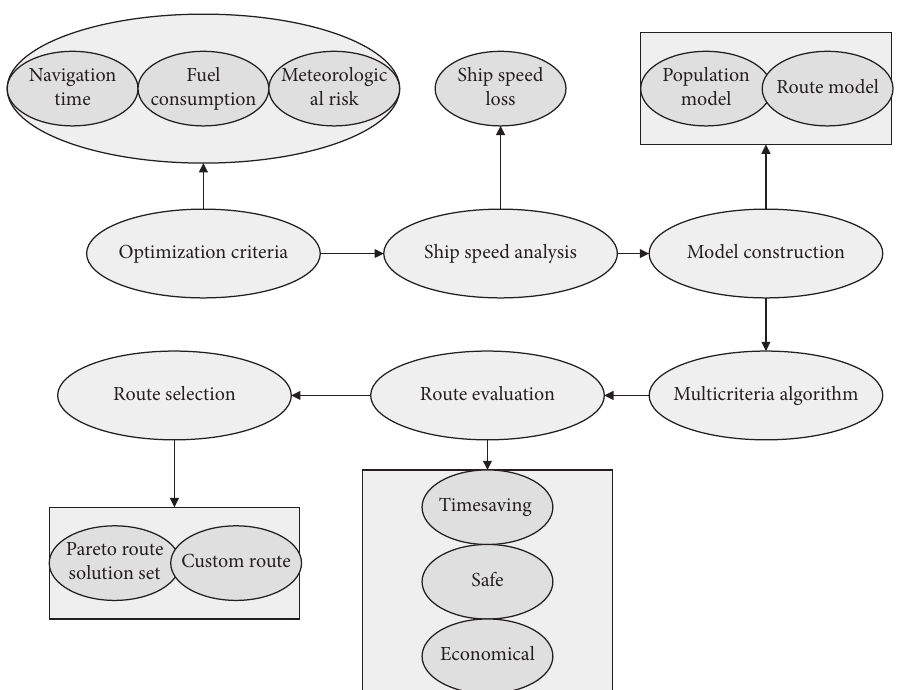
Figure 1: The operational flow of the improved particle swarm